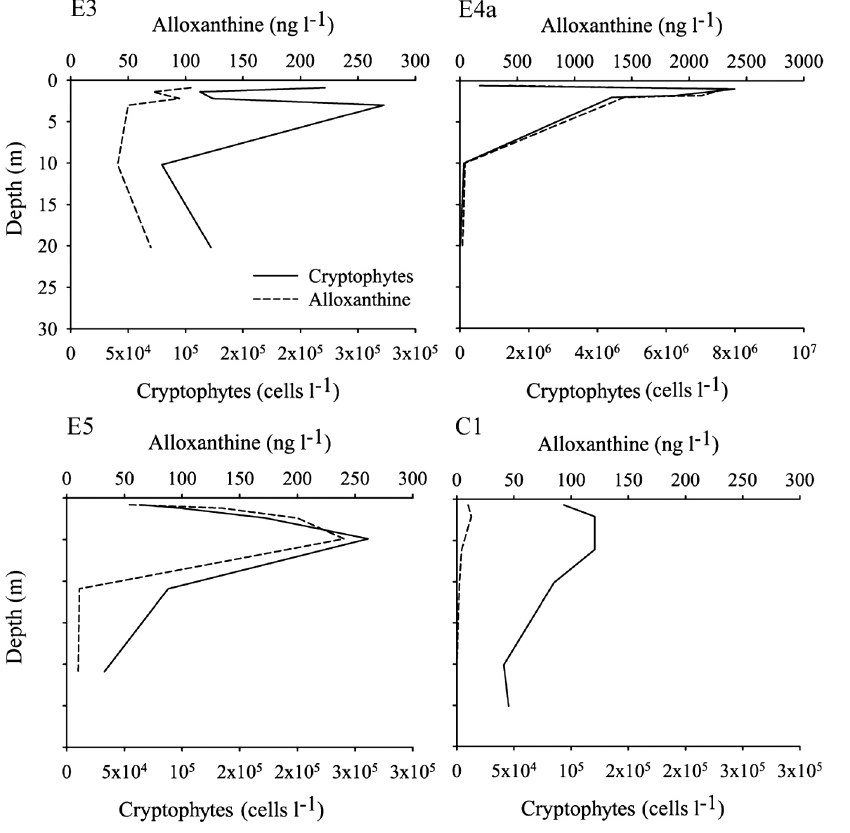
Fig. 4. – Abundance of cryptophytes determined by the LM counts (solid line) and the concentration of the class-specific pigment alloxanthine (dashed line) at the sampled depths. Note the larger scale on the graph representing station